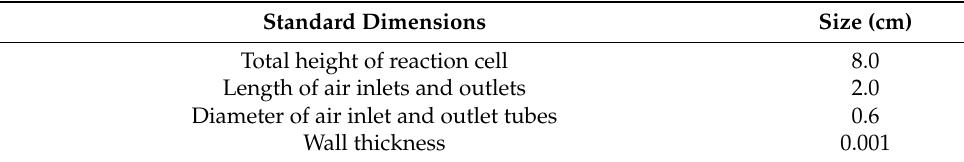
Table 1. Standard construction dimensions used for reaction cells.